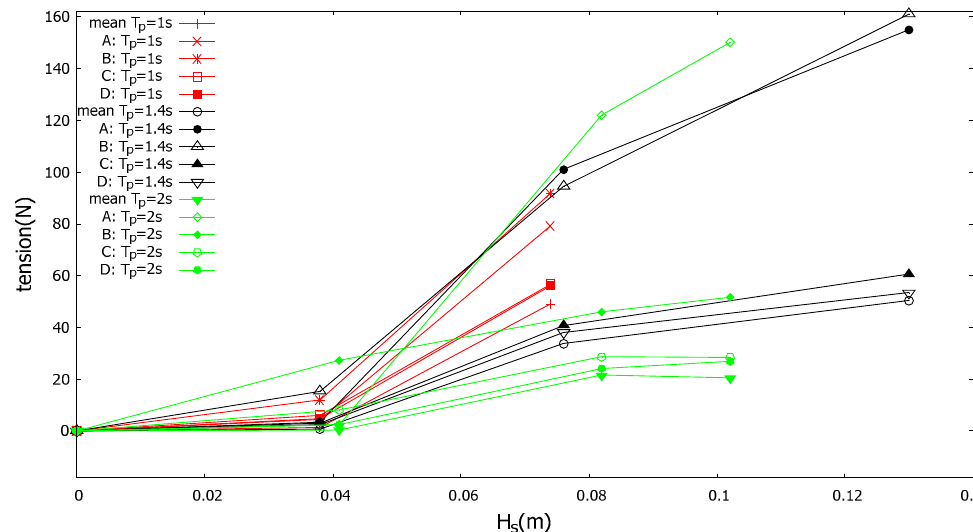
Figure 16. Variation of peak tension with H s for T p = 1, 1.4, 2 s from linear di ff raction / radiation model with measured mean force.